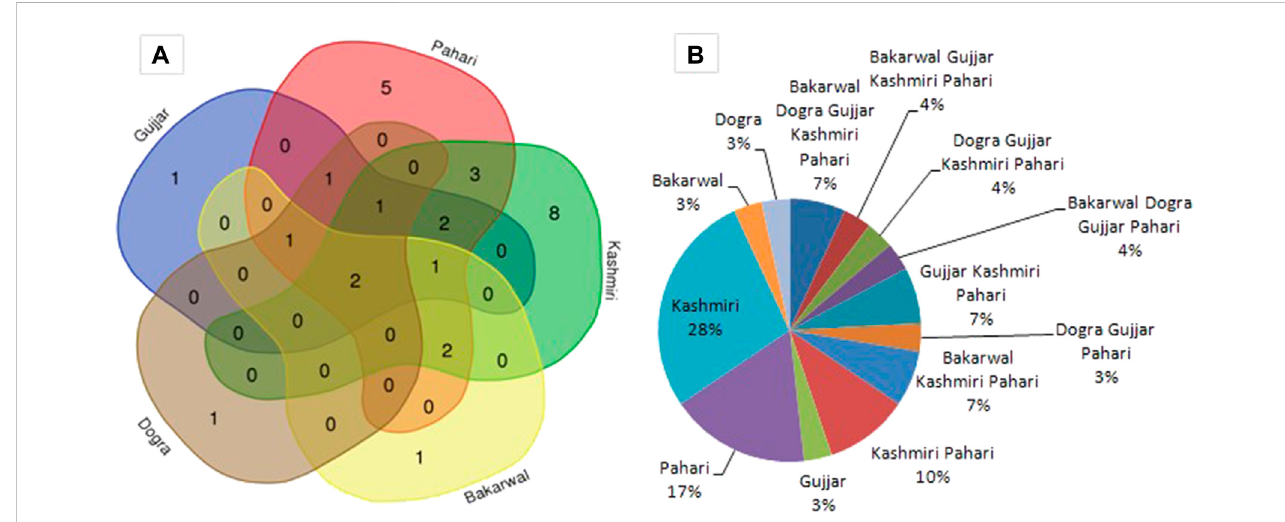
FIGURE 4 (A) Cross cultural use of documented species in diverse groups of Jammu and Kashmir; (B) percentage of similarity between ethnic